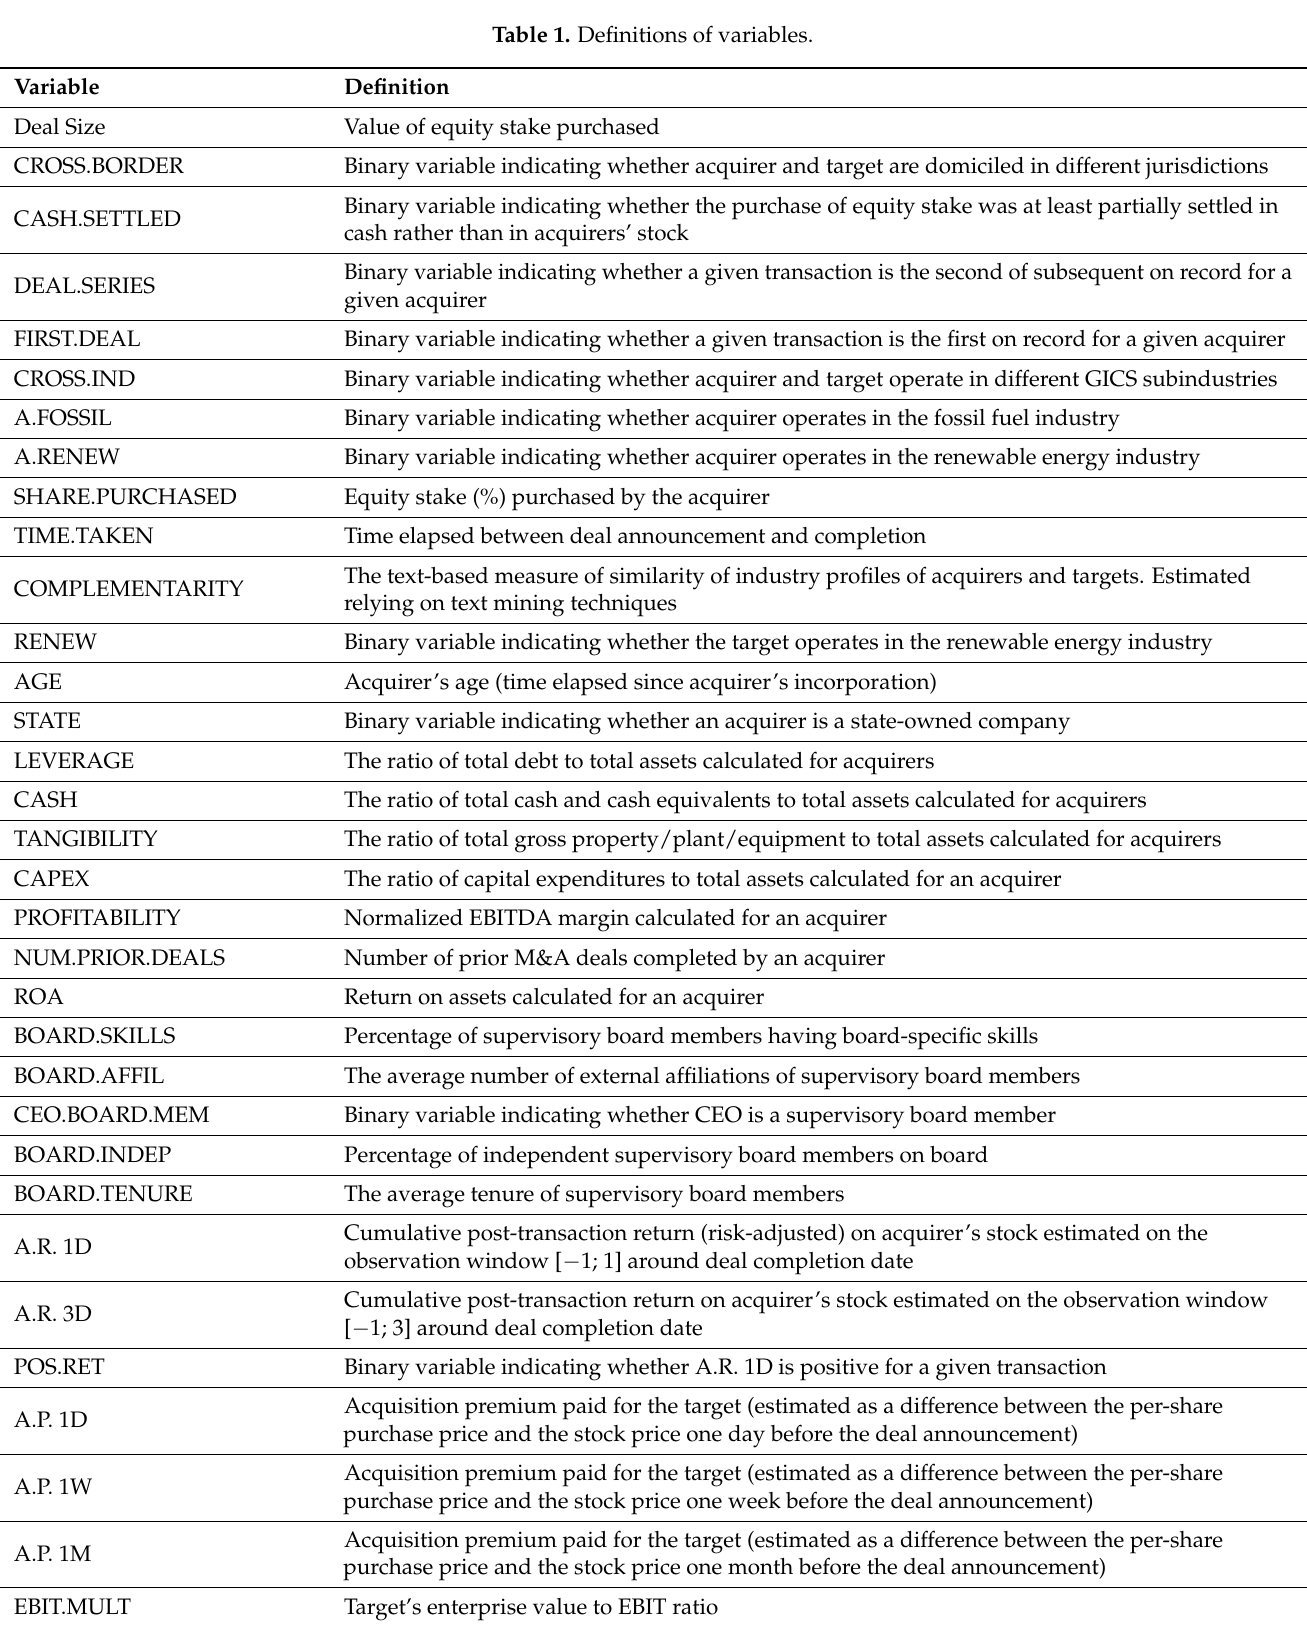
Table 1. Definitions of